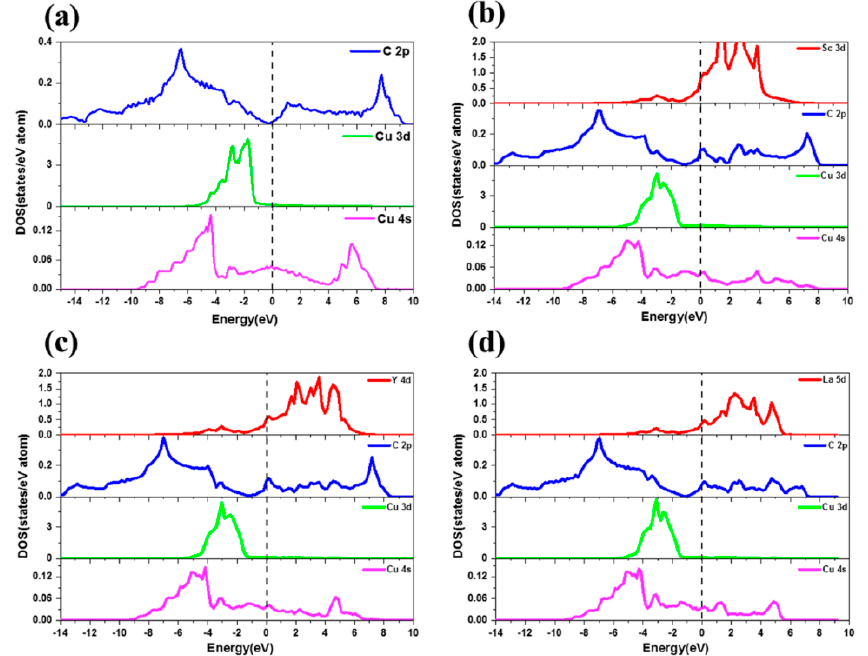
Figure 15. PDOS diagram of Sc–, Y– and La–doped interfaces: ( a ) clean interface; ( b ) Sc–doped interface; ( c ) Y–doped interface; ( d ) La–doped interface [41]. Reprinted/adapted with permission from Ref. [41]. Copyright year 2022, Elsevier.